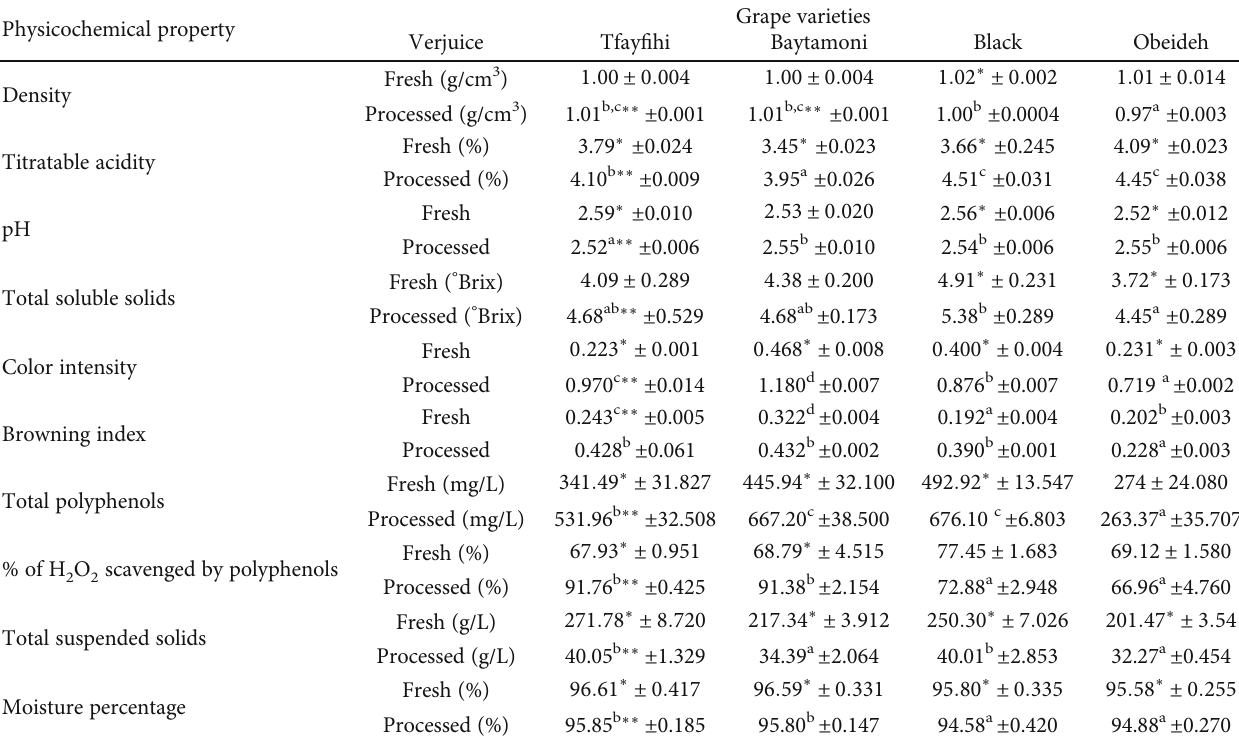
Table 1: Physicochemical properties of processed and fresh unripe grape